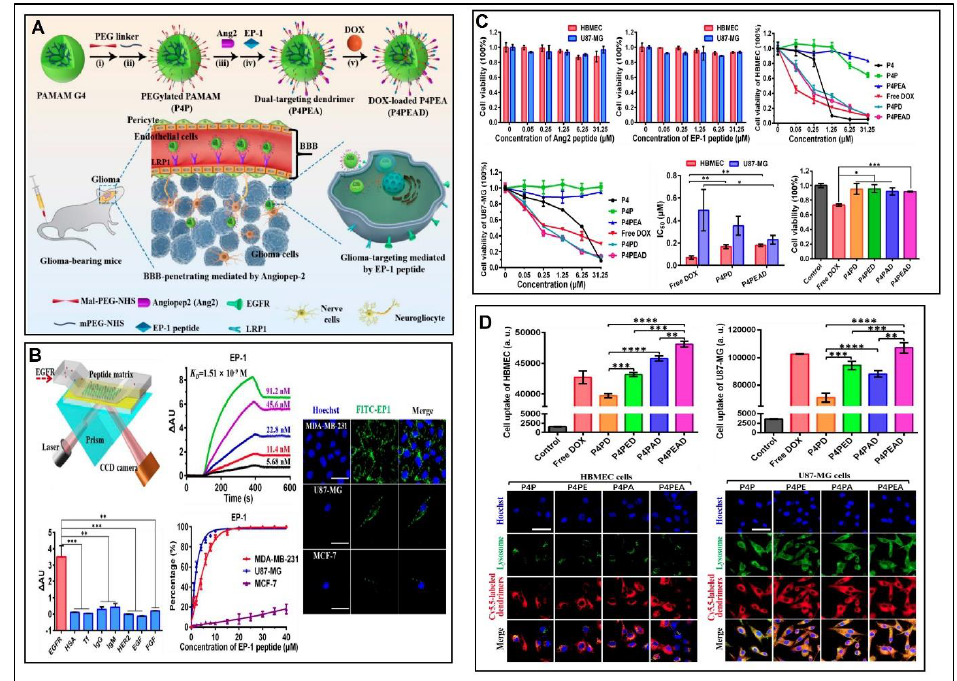
Figure 6. ( A ) Schematic representation of fabrication of the dual drug loaded polyamidoamine (PAMAM) dendrimers in the treatment of gliomas by improving BBB penetration; ( B ) Assessment of the a ffi nity and specificity of peptide EP-1 toward EGFR; ( C ) In vitro evaluation of biocompatibility and anti-tumor e ffi cacy of the dual drug-loaded PAMAM dendrimers; ( D ) Flow cytometry evaluation for intracellular uptake of di ff erent DOX-loaded dendrimers. Reprinted from [148] Ivyspring International Publisher, 2020. * p < 0.1, ** p < 0.01, *** p < 0.001, **** p < 0.0001 (Student’s t -test).